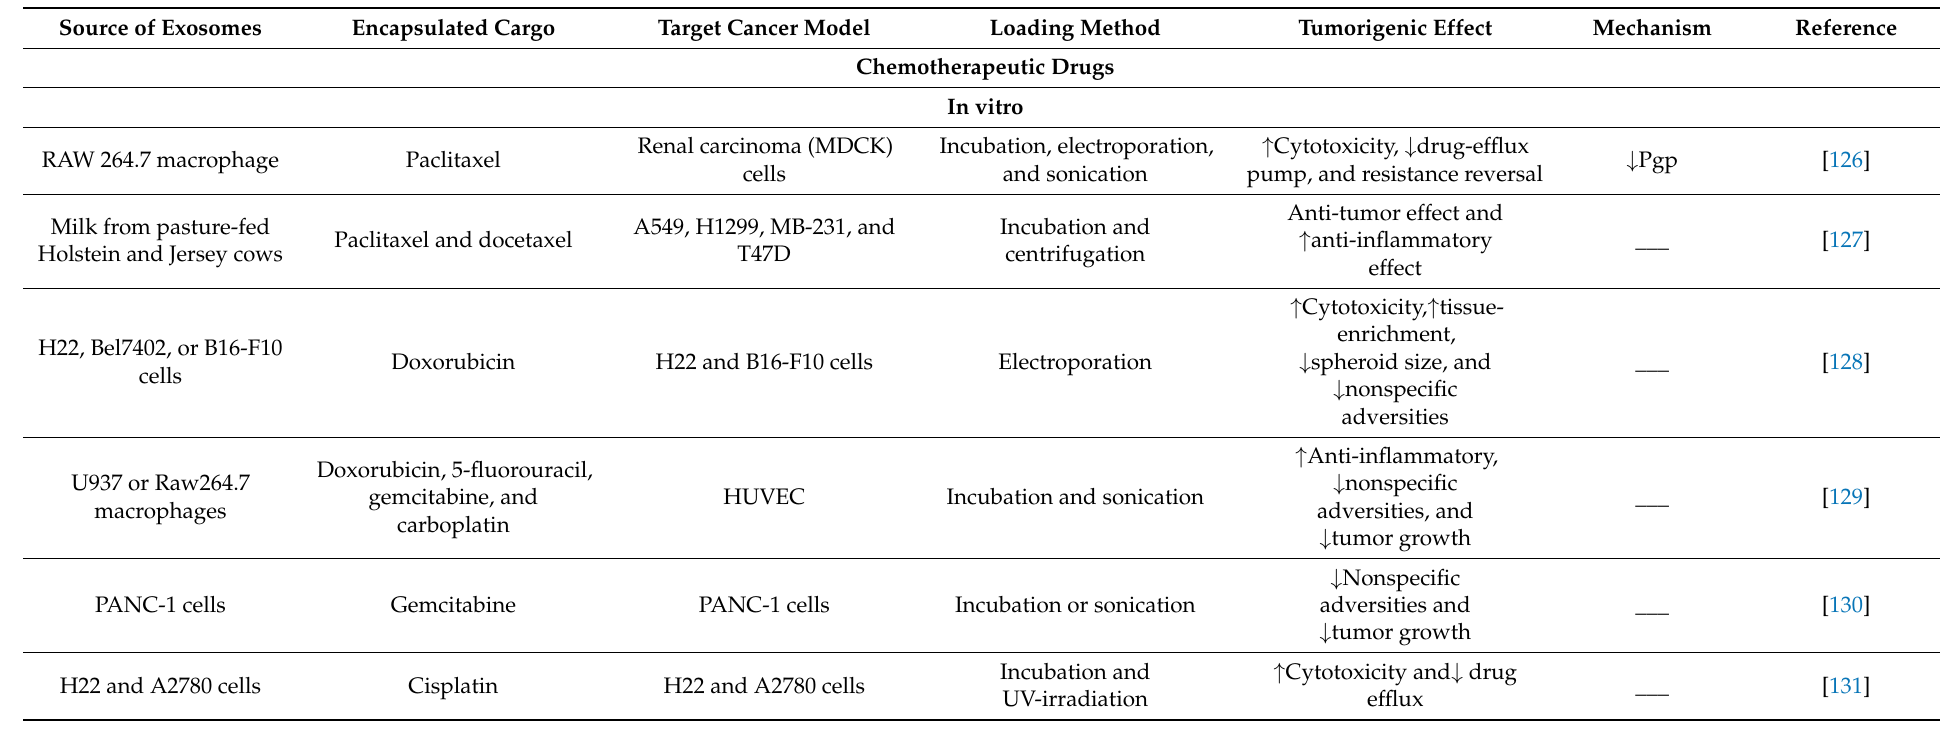
Table 4. Exosomal bioengineering for cancer diagnosis and